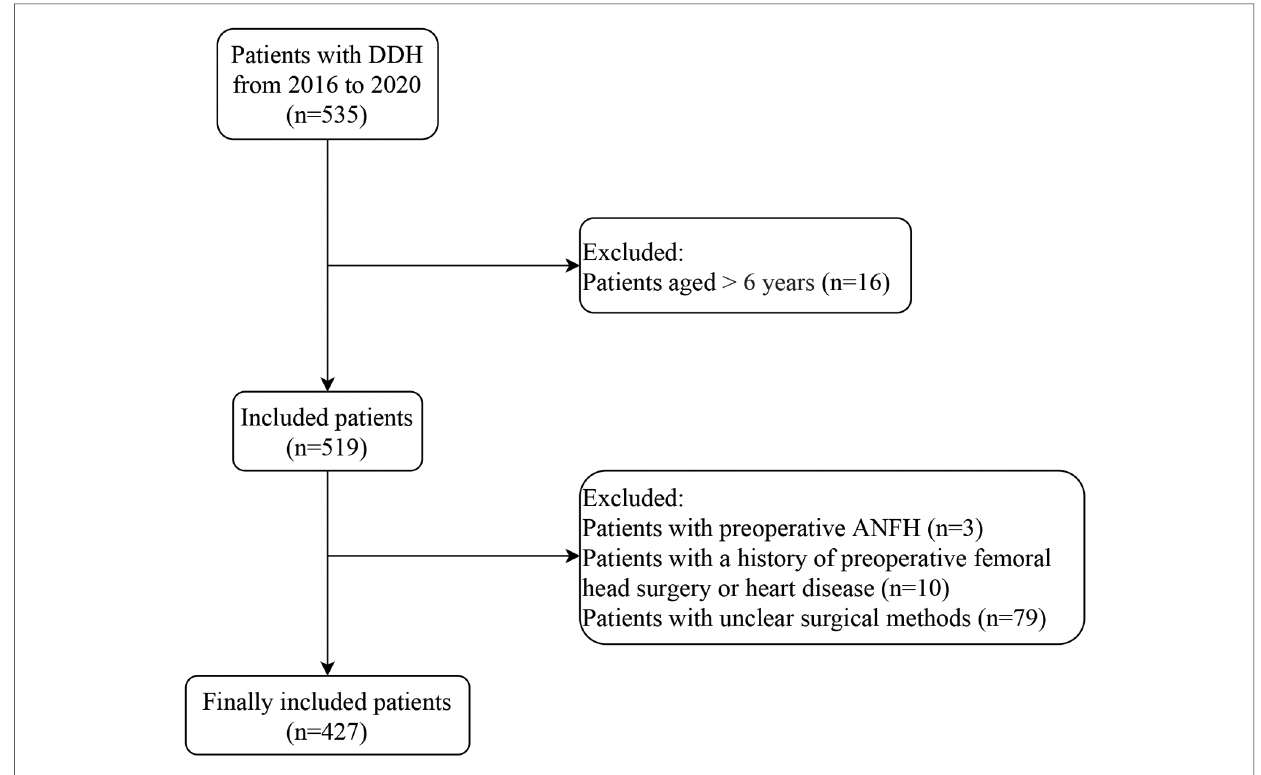
FIGURE 1 Flow chart of study population screening.DDH, developmental dysplasia of the hip; ANFH, avascular necrosis of the femoral